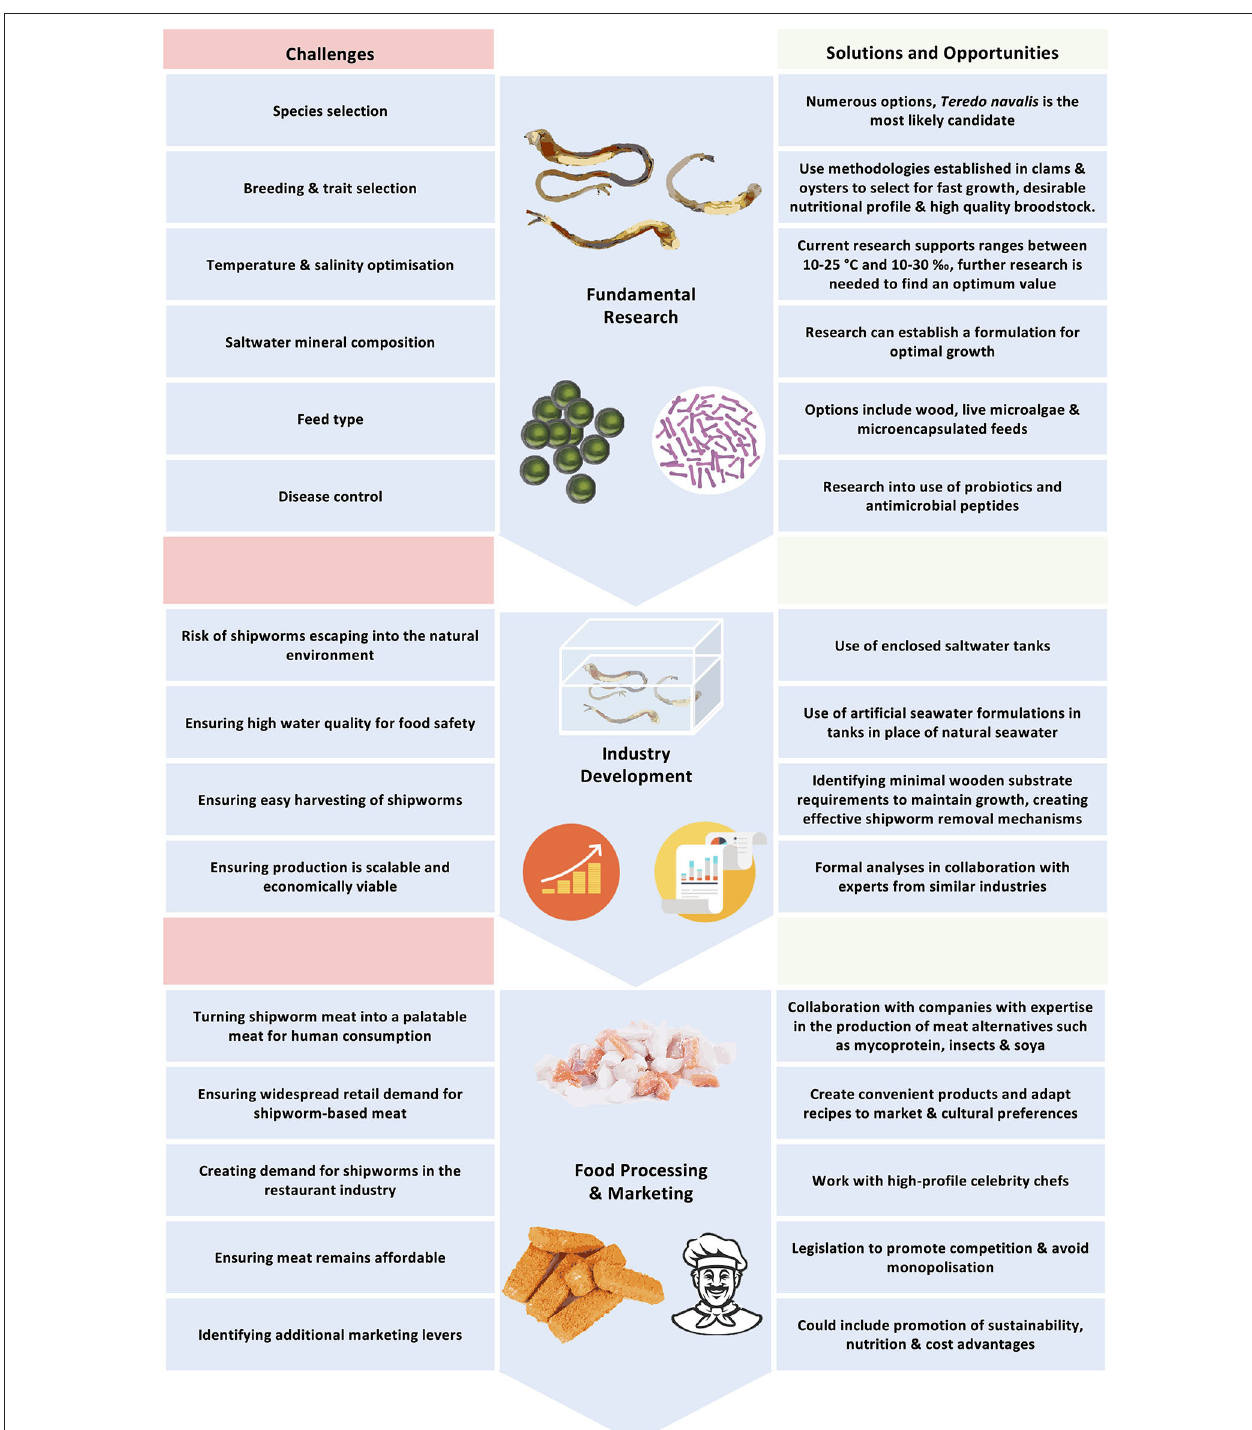
FIGURE 2 | Key challenges, solutions and opportunities in the development of shipworm aquaculture.